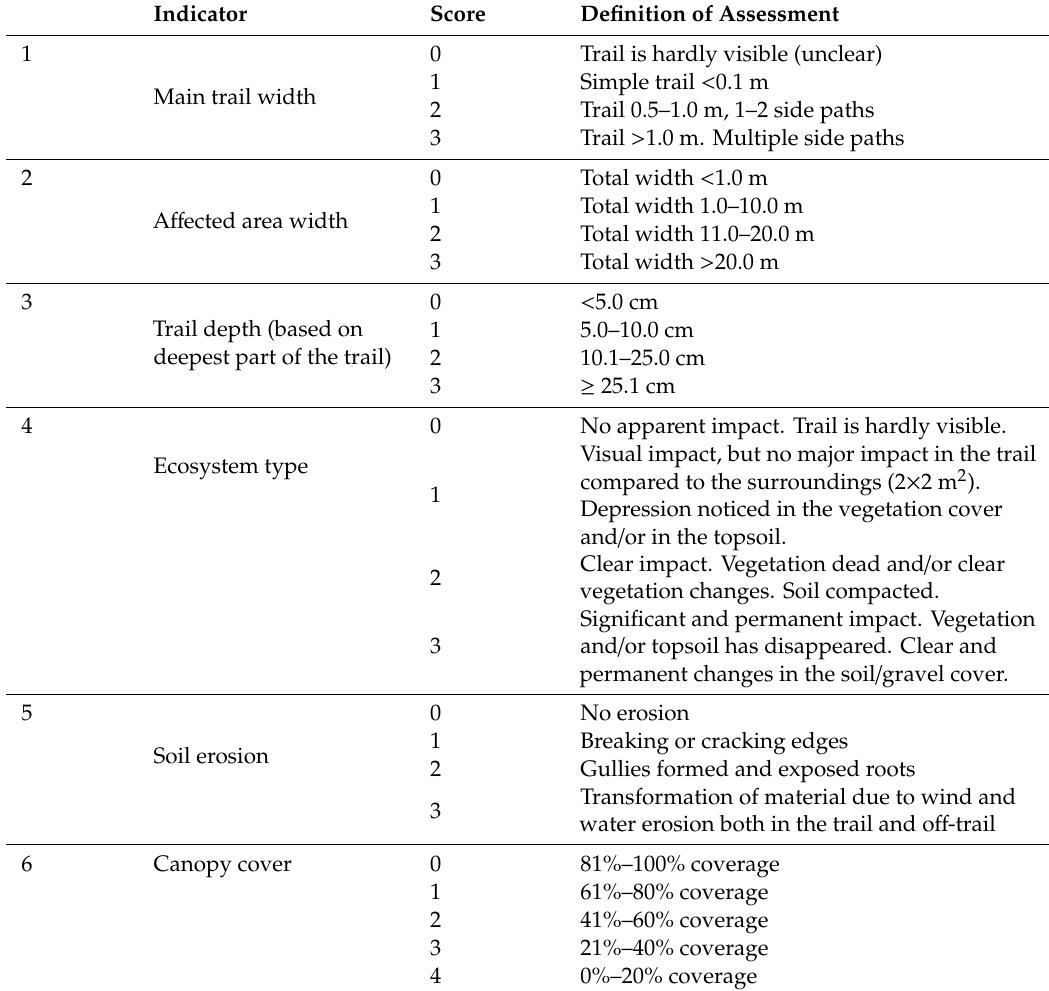
Table 2. Classification system for hiking trail condition assessment and forest canopy coverage, which was adapted from the description in [25] with minor adjustments to fit the geographical condition of Guangdong